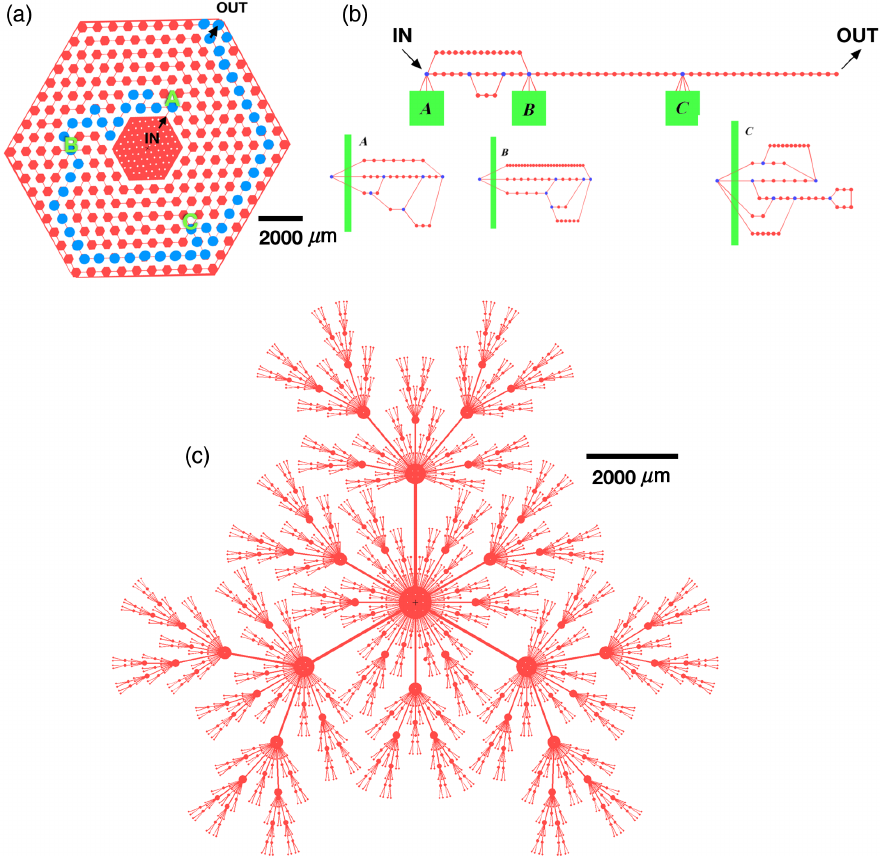
FIG. 1. (a) A non-simply-connected maze. Bacteria are introduced in the center. The shortest path is shown in blue hexagons. (b) Three nodes with high branching levels labeled A , B , and C are shown. (c) A fractal of dimension D ¼ 2 . 90 . Bacteria are introduced in the center